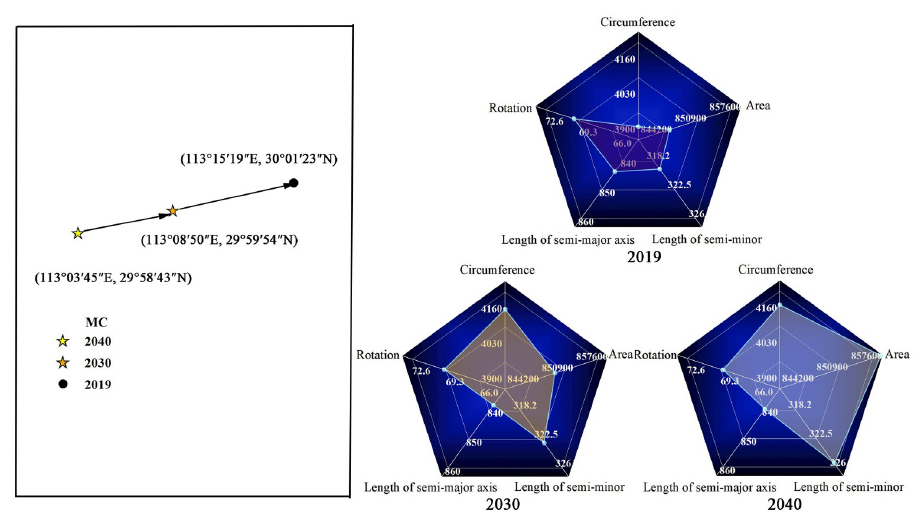
Fig 7. Forecast of the spatial pattern.